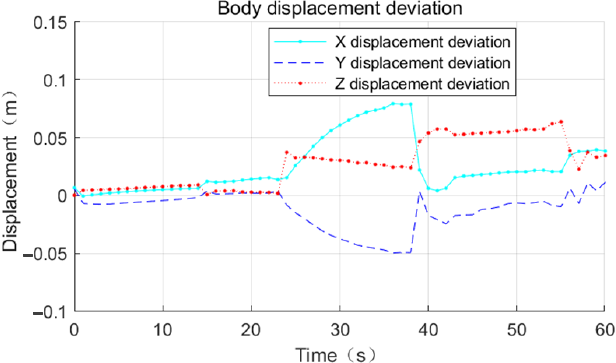
Figure 14. Deviation of base joist crawling displacement.